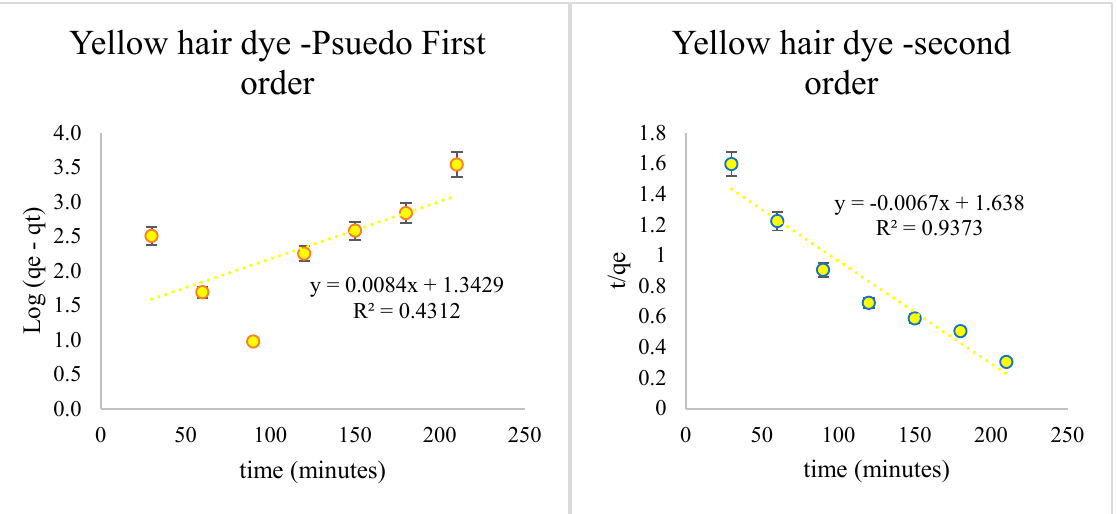
Figure 9. Kinetic studies of the adsorption of yellow hair dye onto COZ, [dosage = 0.07 g R, 0.06 g Y, & 0.05 E, C i = 50 mg·L − 1 , pH = 7.0, contact time = 120 min for R and E, 150 min for Y, T = 25 ± 1 °C, speed = 150 rpm].